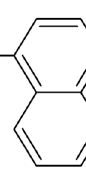
Figure 4. Structure of C 16 H 12 N 2 .